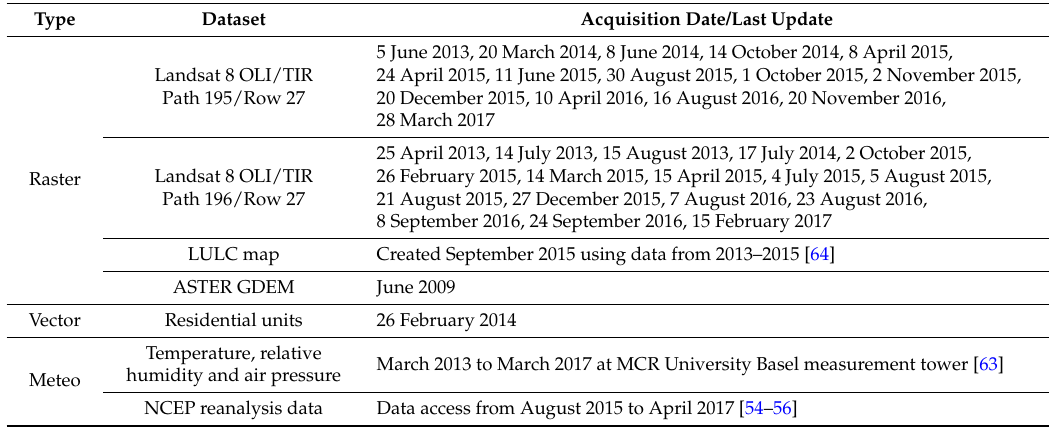
Figure 1. LULC map of Basel and its surroundings using the modal value of seven individual classifications from 2013 to 2015. The coordinate system is UTM-32N and the pixel resolution 15 m (pan-sharpened). The national borders are represented by black and the Canton of Basel-Stadt by gray lines, a shaded relief overlay using resampled SRTM data depicts the topography. The vegetation represents an overpass of 30 August 2015. Table 1. Different datasets with acquisition date used for this study.